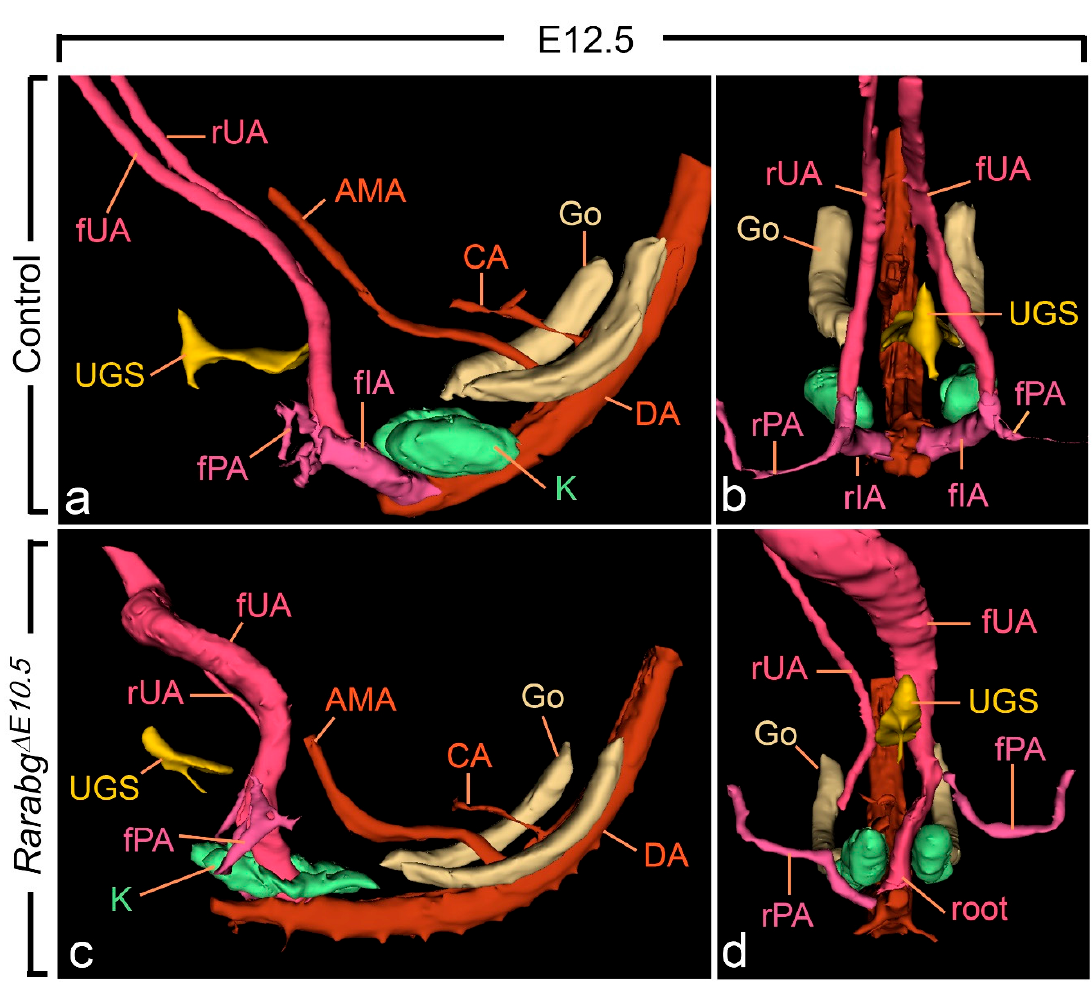
Figure 6. Left lateral ( a , c ) and ventral ( b , d ) views of the urogenital sinus (UGS), kidneys, gonads and arteries in control and Rarabg ∆ E10.5 mutant embryos at E12.5. ( a , b ) In the control, the left and the right umbilical arteries have similar calibres; their roots have yielded the common iliac arteries. ( c , d ) In the mutant, the right umbilical root has regressed; the left root is in a median position and is hyperplastic as it carries the whole umbilical circulation; the principal artery to the right hindlimb bud connects directly to the dorsal aorta. AMA, anterior mesenteric artery; CA, coeliac artery; DA, midline dorsal aorta; Go, gonad; K, metanephric mesenchyme; rIA and fIA, right and left common iliac arteries; rPA and fPA, right and left arteries to the hindlimb buds; root, root of the single umbilical artery in the mutant; rUA and fUA, right and left umbilical arteries. UGS, lumen of the urogenital sinus. Same magnification in ( a – d ).